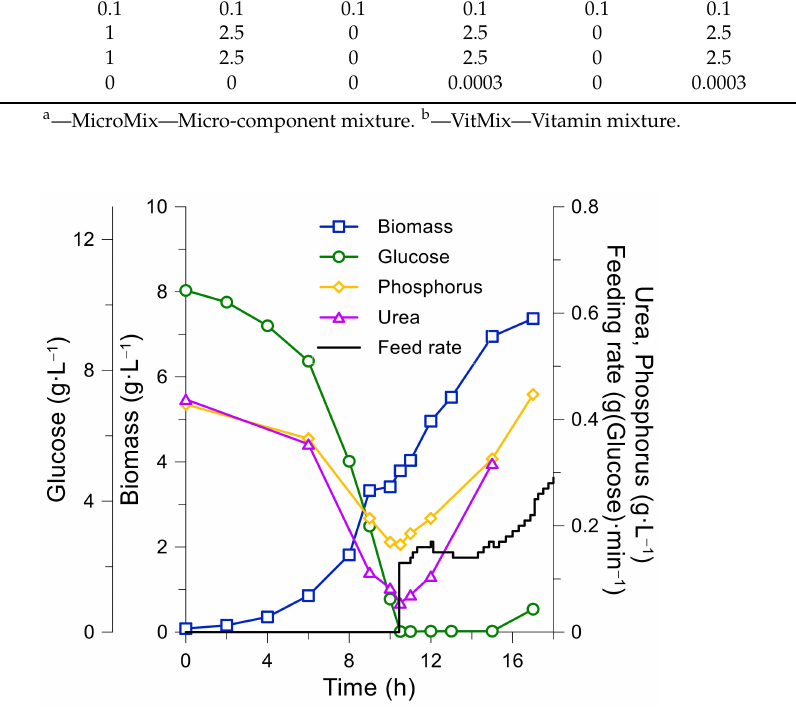
Figure 4. K. marxianus first bioreactor fed-batch cultivation using the initial growth media and feeding solution compositions (see Table 3, Process